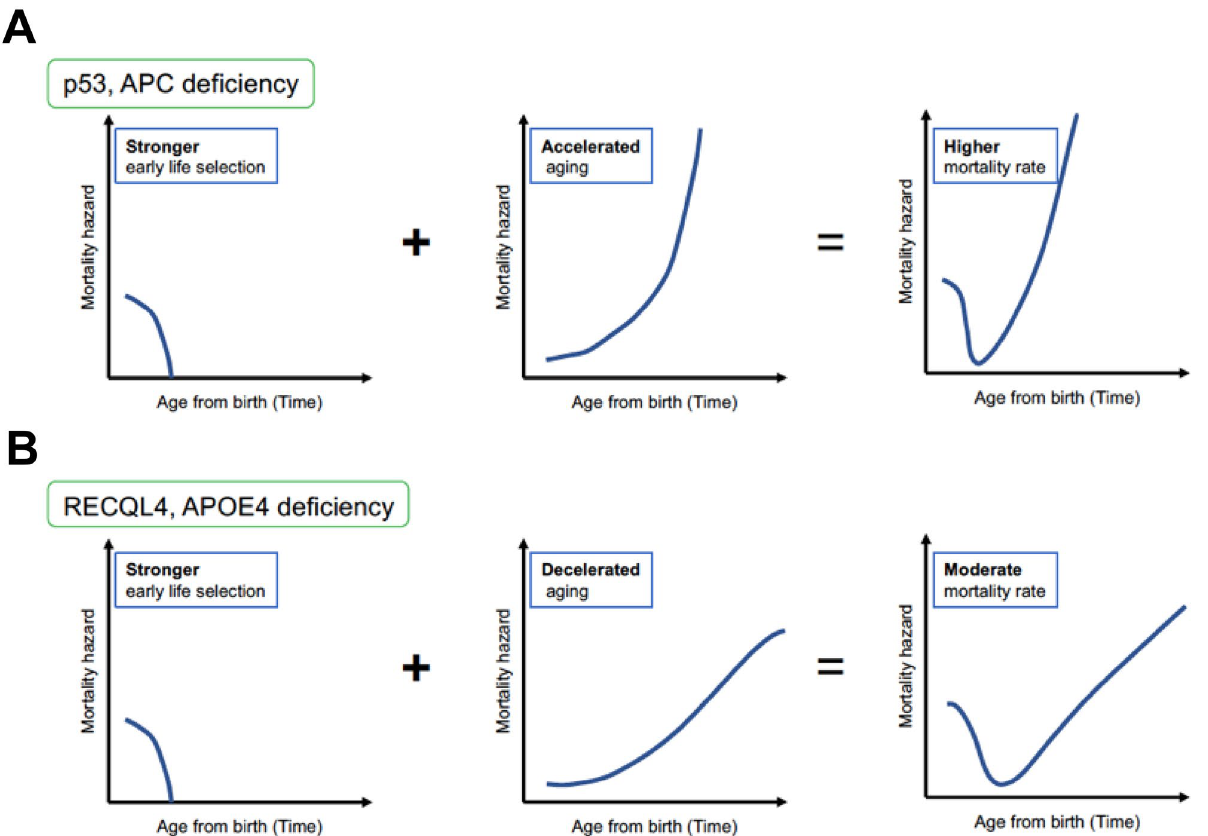
Figure 7. A proposed model for distinguishing between two different types of tumor suppressor gene-deficient mice to explain the difference in lifespan. ( A ) APC or p53 genes might play protective roles in early life selection and aging as expected in Fig. 1B. ( B ) Given the decrease in reproduction observed in RECQL4-deficient mice, we hypothesize that RECQL4 might exert a negative effect on aging and that the lifespan of RECQL4-deficient mice would be the outcome of the combined effect of stronger early life selection and decelerated aging. Refer to the Discussion for APOE4-deficient mice, which might exhibit a lifespan similar to that of RECQL4-deficient mice under certain environmental